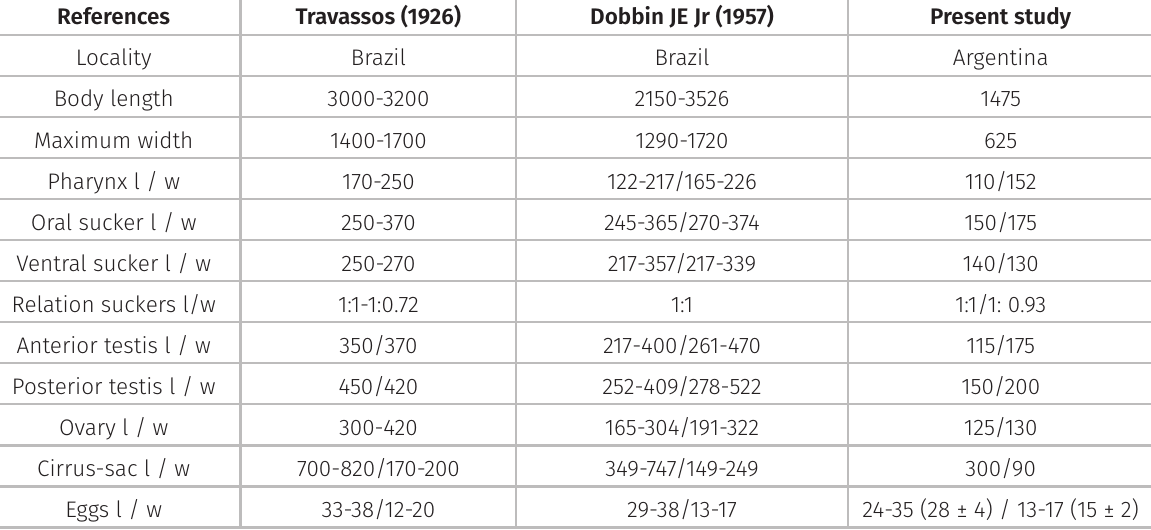
Table II. Comparative morphometrics of Choledocystus elegans found in Lepidobatrachus laevis from the Chacoan region,